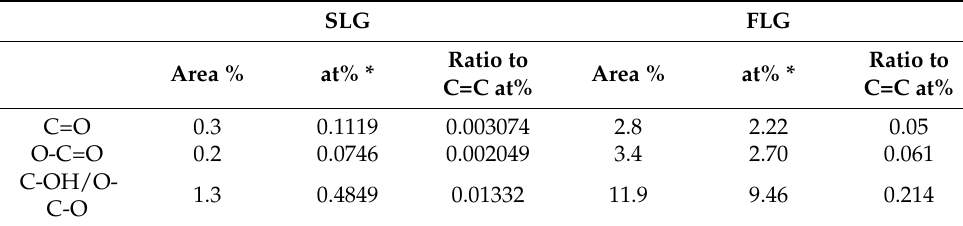
Table 1. Summary of the oxygen-containing groups obtained from XPS spectra of SLG and FLG. SLG FLG Ratio to Ratio to Area % at% * Area % at% * C=C at% C=C at% C=O 0.3 0.1119 0.003074 2.8 2.22 0.05 O-C=O 0.2 0.0746 0.002049 3.4 2.70 0.061 C-OH/O- 1.3 0.4849 0.01332 11.9 C-O